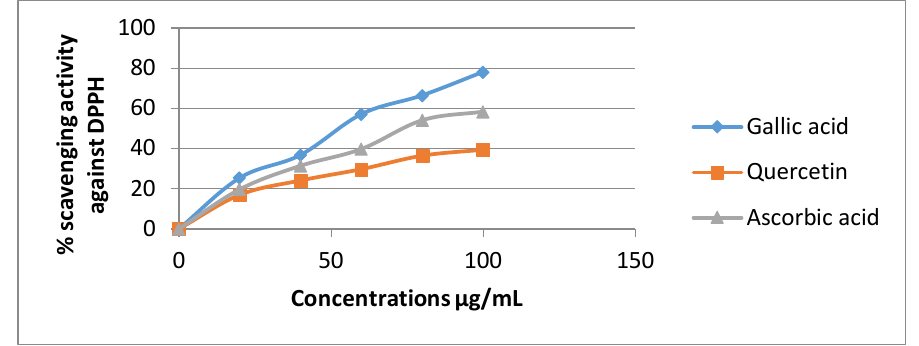
Figure 1. Inhibition of DPPH radical by the standards at different concentrations.